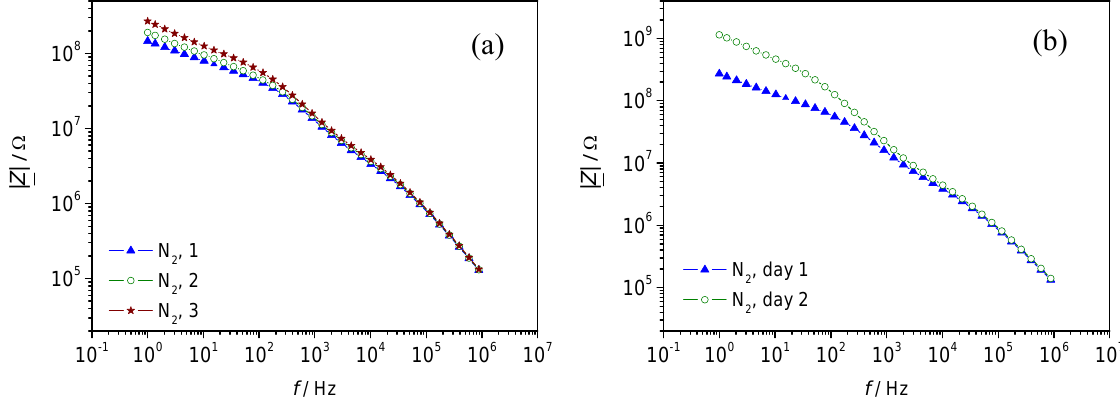
Figure 3. Reproducibility of the impedimetric sensor signal (| Z |) in N Frequency range 1 Hz - 1 MHz. Pellet-type sensor of Al-BDC. (a) Repeatability of the sensor characteristics in three consecutive measurements. (b) Repeatability at two consecutive days. All measurements performed with the same pellet. T =